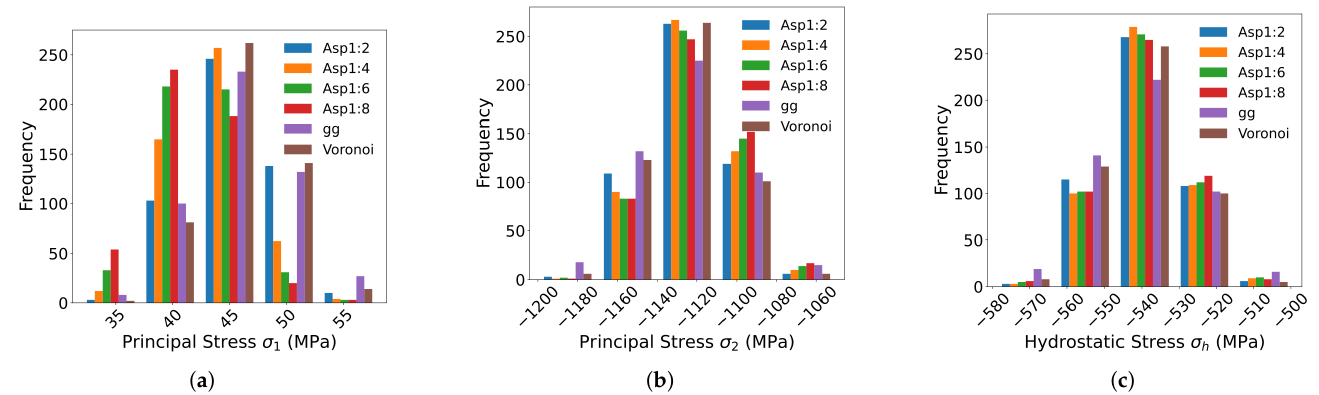
Figure 2. Distribution of ( a ) principal stress σ 1 ( b ) principal stress σ 2 and ( c ) hydrostatic stress σ h across different grain structures.